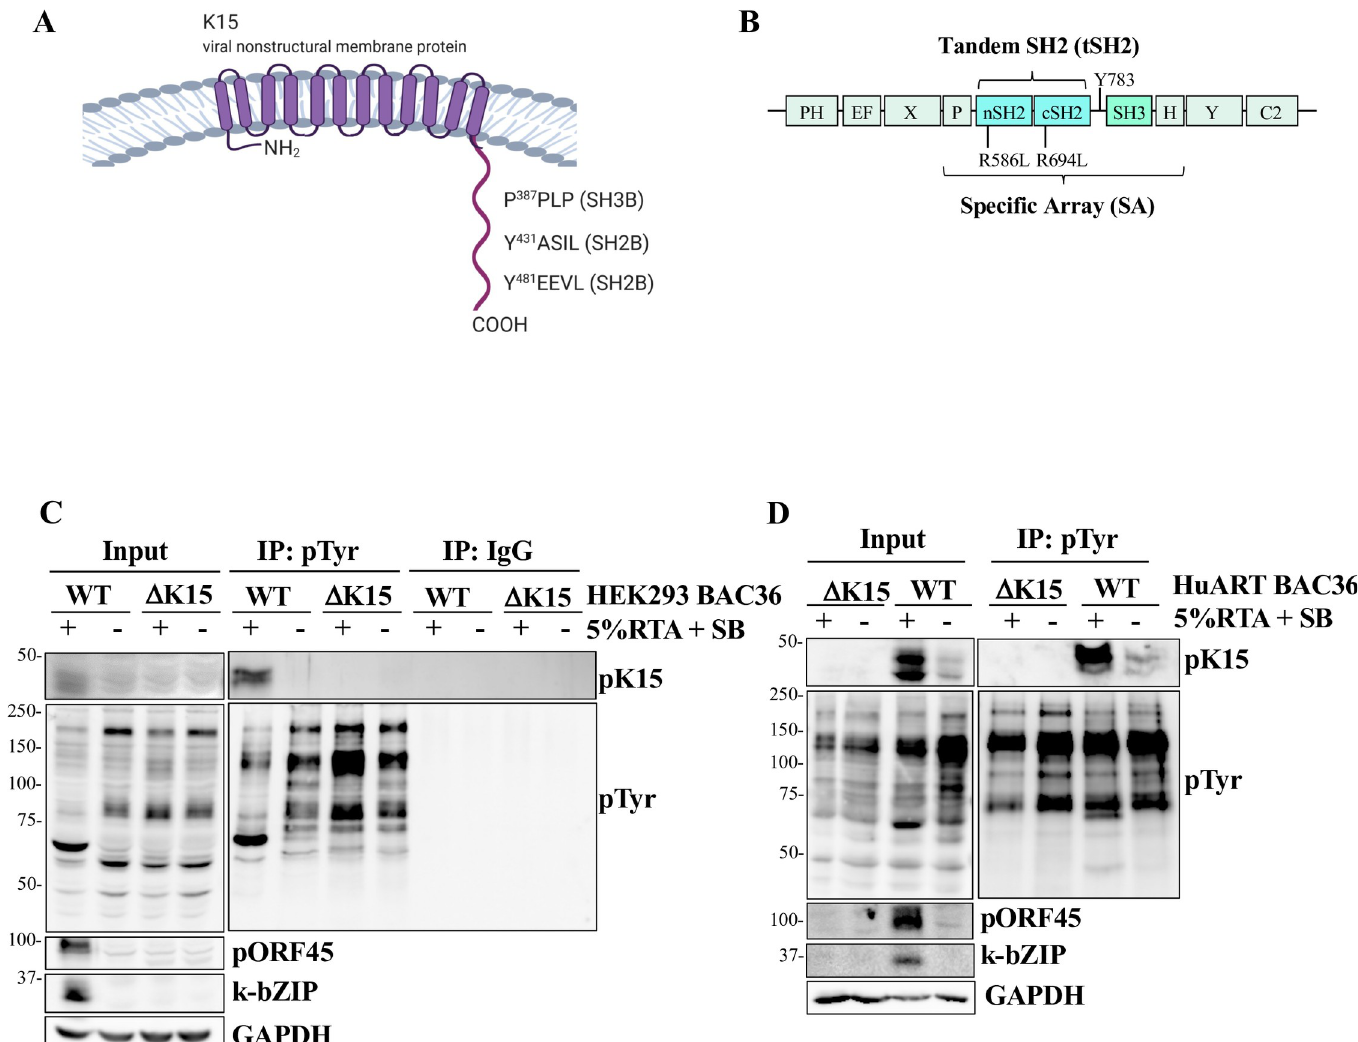
Fig 1. Full length K15 is phosphorylated in KSHV infected cells. (A) Diagram of the non-structural KSHV membrane protein pK15. Regions in its C-terminal domain discussed in this manuscript are indicated. (B) Diagram of PLC γ 1. The position of the γ -specific array (SA), the tandem SH2 domain (tSH2) and the individual SH2 domains is shown. R 586 L and R 694 L refer to mutants in the nSH2 or cSH2 domain, Y 783 to the tyrosine residue in the cSH2-SH3 linker segment. (C) HEK-293 stably transfected with BAC36 KSHV WT or BAC36 KSHV Δ K15 were seeded in tissue culture flasks, followed after 24 hours by activating the lytic cycle by adding 5% tissue culture supernatant from insect cells expressing KSHV RTA and Na-butyrate (SB) (+); control cultures were not activated (-). Cells were lysed 48h after reactivation and immunoprecipitated with an antibody to pTyr or control IgG. (D) HuAR2T cells that had been stably infected with BAC36 KSHV WT or BAC36 KSHV Δ K15 virus (produced in HEK293 BAC36 KSHV WT or BAC36 KSHV Δ K15 cells) were plated in a 15 cm dish. After 48h the lytic cycle was induced as in (C) and 48h after reactivation cells were lysed and immunoprecipitated as in panel C.